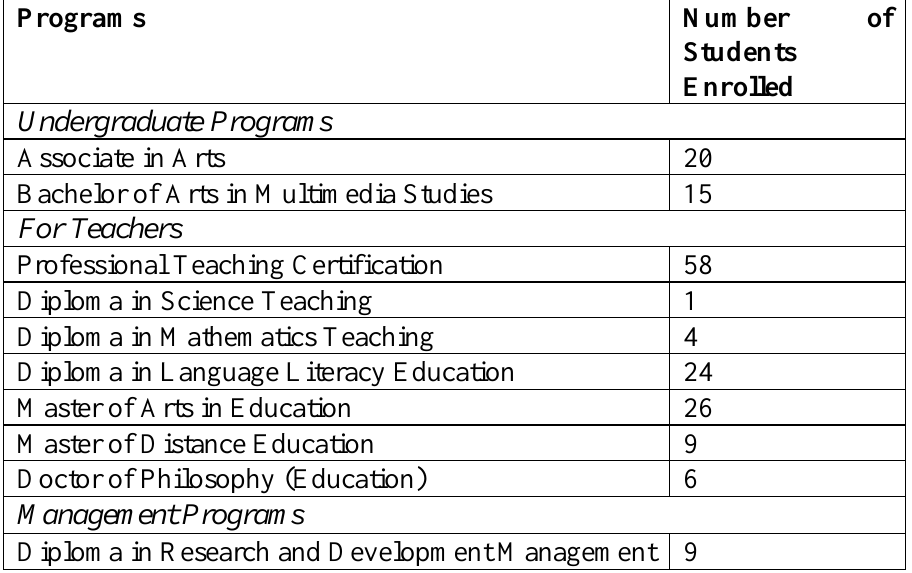
Table 2: Number of students enrolled per program (Second Semester 2009-2010)